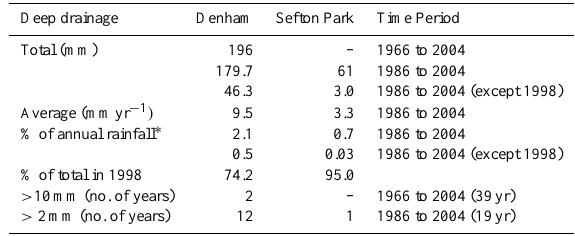
Table 3. Simulated deep drainage over time and as a proportion of rainfall 1966 to